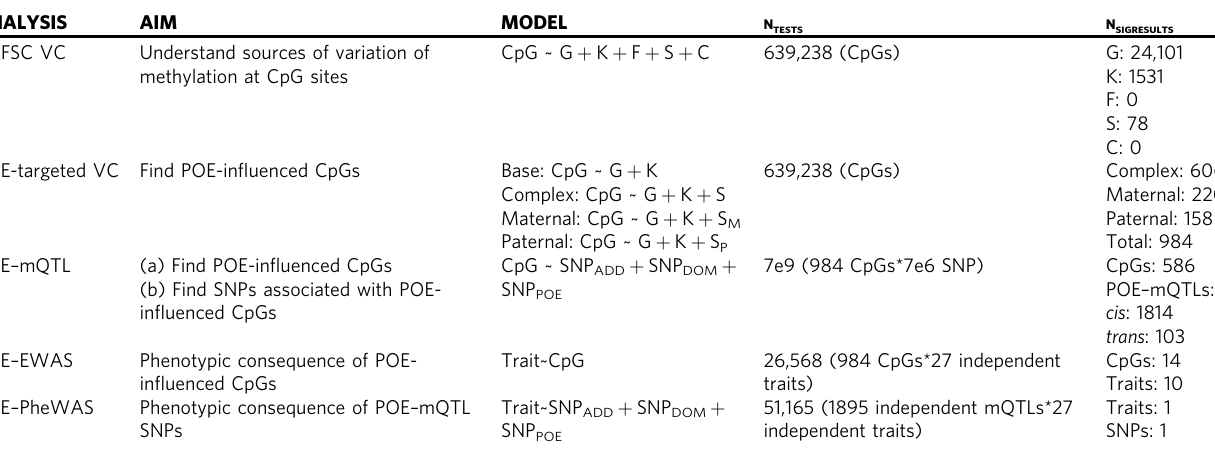
The table shows an overview of the analyses performed (ANALYSIS), describing their aims (AIM) and the models used (MODEL), as well as the number of tests performed (N tests ) and the number of signi fi cant results obtained ( N SIGRESULTS ) GKFSC VC variance component analyses to partition methylation level variation into its additive genetic (G: SNP associated, K: pedigree associated) and non-additive/environmental (F: family, S: sibling, C: couple) components, SNP single-nucleotide polymorphism POE-targeted VC modi fi ed variance component analysis detects candidate methylation sites with parent-of-origin inheritance pattern (parent-of-origin effect, POE). Base: model without POE; complex: model including a complex POE component allowing for increased similarity between siblings; maternal: model including a POE component (S M ) allowing for increased similarity between father and offspring and siblings; paternal: model including a POE component (Sp) allowing for increased similarity between mother and offspring and siblings; POE – mQTL parent-of-origin effect methylation quantitative trait loci analyses, ADD Additive effect, DOM dominance effect, POE – EWAS , complex trait association with methylation levels of POE CpGs, POE – PheWAS , phenotype-wide association study accounting for parent-of-origin effects for parent-of-origin methylation level associated loci (POE –